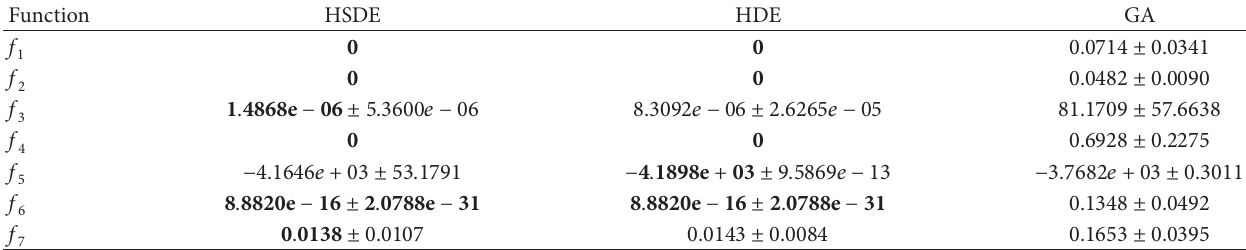
Table 3: Results of seven functions with three algorithms ( 𝐿 = 10 ).